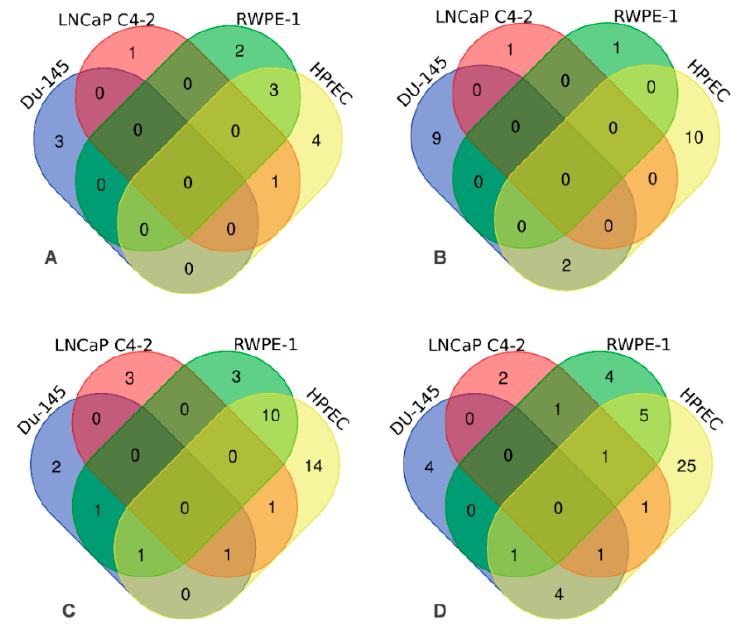
Figure 4. Venn diagrams depicting number of genes significantly affected ( p < 0.05) by NaA-silanePEG and NaA-silane-PEG-D2B nanocarriers in LNCaP C4-2, DU-145, RWPE-1 and HPrEC cells. The effect of NaA-silane-PEG on number of genes involved in autoimmune and inflammatory responses ( A ) and in NF- κ B signaling ( B ). The effect of NaA-silane-PEG-D2B on the number of genes involved in autoimmune and inflammatory responses ( C ) and in NF- κ B signaling ( D ).